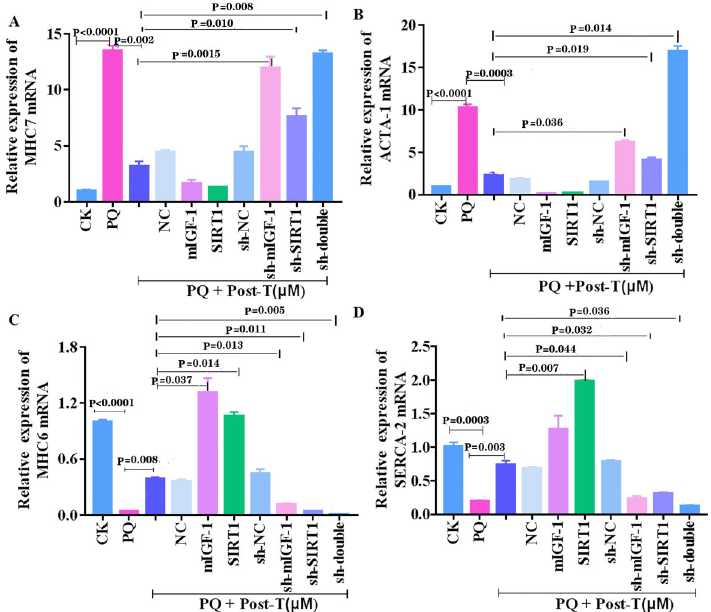
Figure 3. Testosterone (T) changed the gene expression of the contractile protein/enzyme via mediating mIGF-1/SIRT1 pathway in HL-1 cardiomyocytes. The expressions of MHC7 mRNAs ( A ), ACTA-1 mRNAs ( B ), MHC6 mRNAs ( C ), and SERCA2 mRNAs ( D ) were examined by qRT-PCR. Data are reported as means ± SE of four independent experiments (ANOVA and Dunnett ’ s multiple comparisons test). PQ: paraquat; CK: control; NC: negative